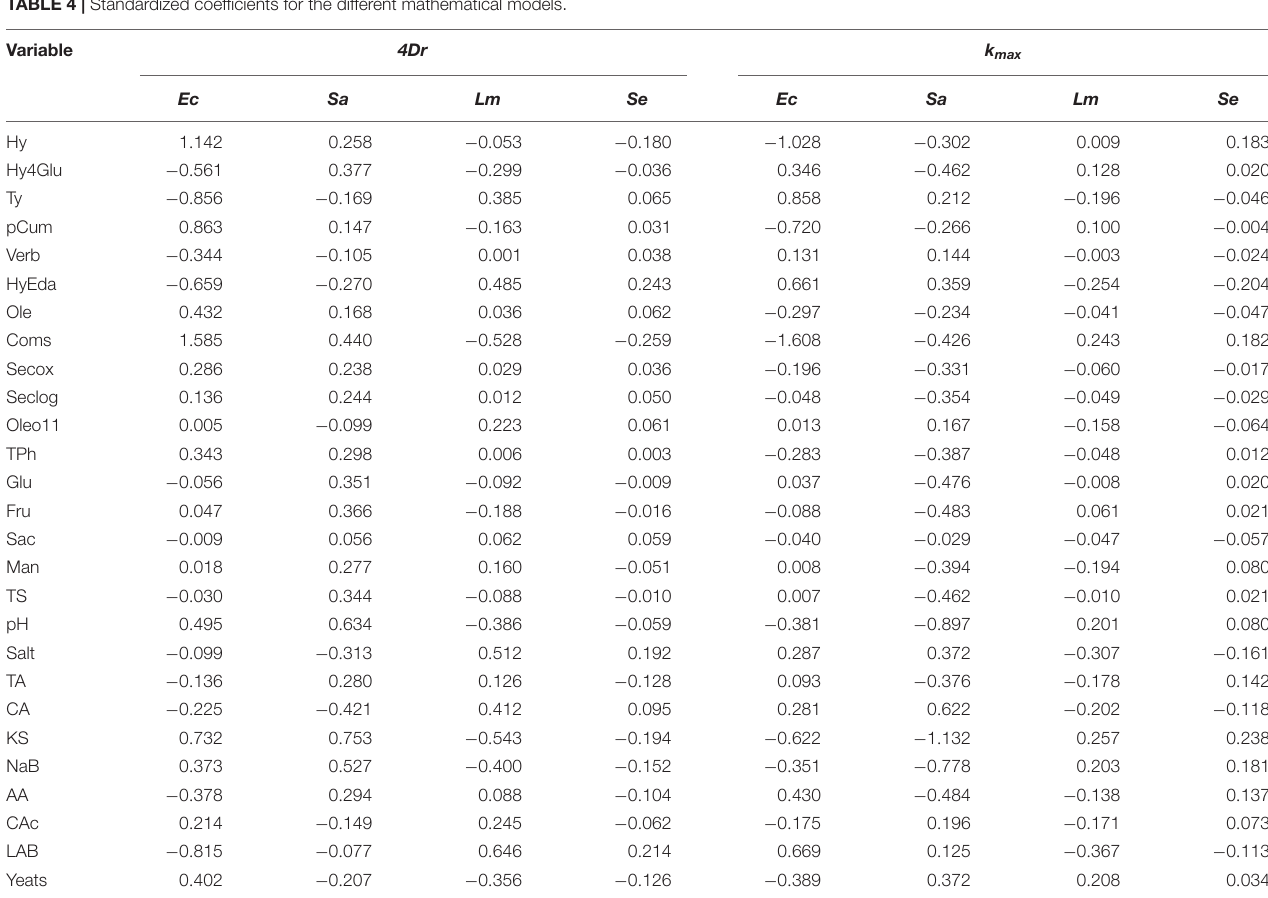
TABLE 4 | Standardized coefficients for the different mathematical